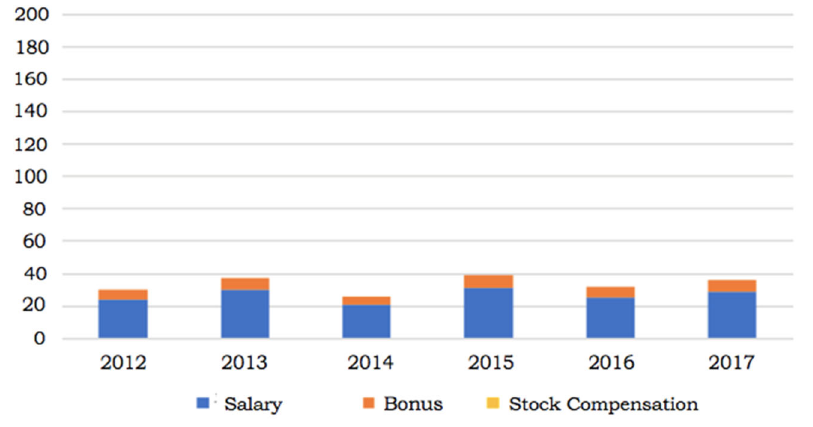
Figure 6. Classified average executive compensation in NTT Docomo Note: Vertical axis indicates the amount of average executive compensation and horizontal axis indicates fiscal